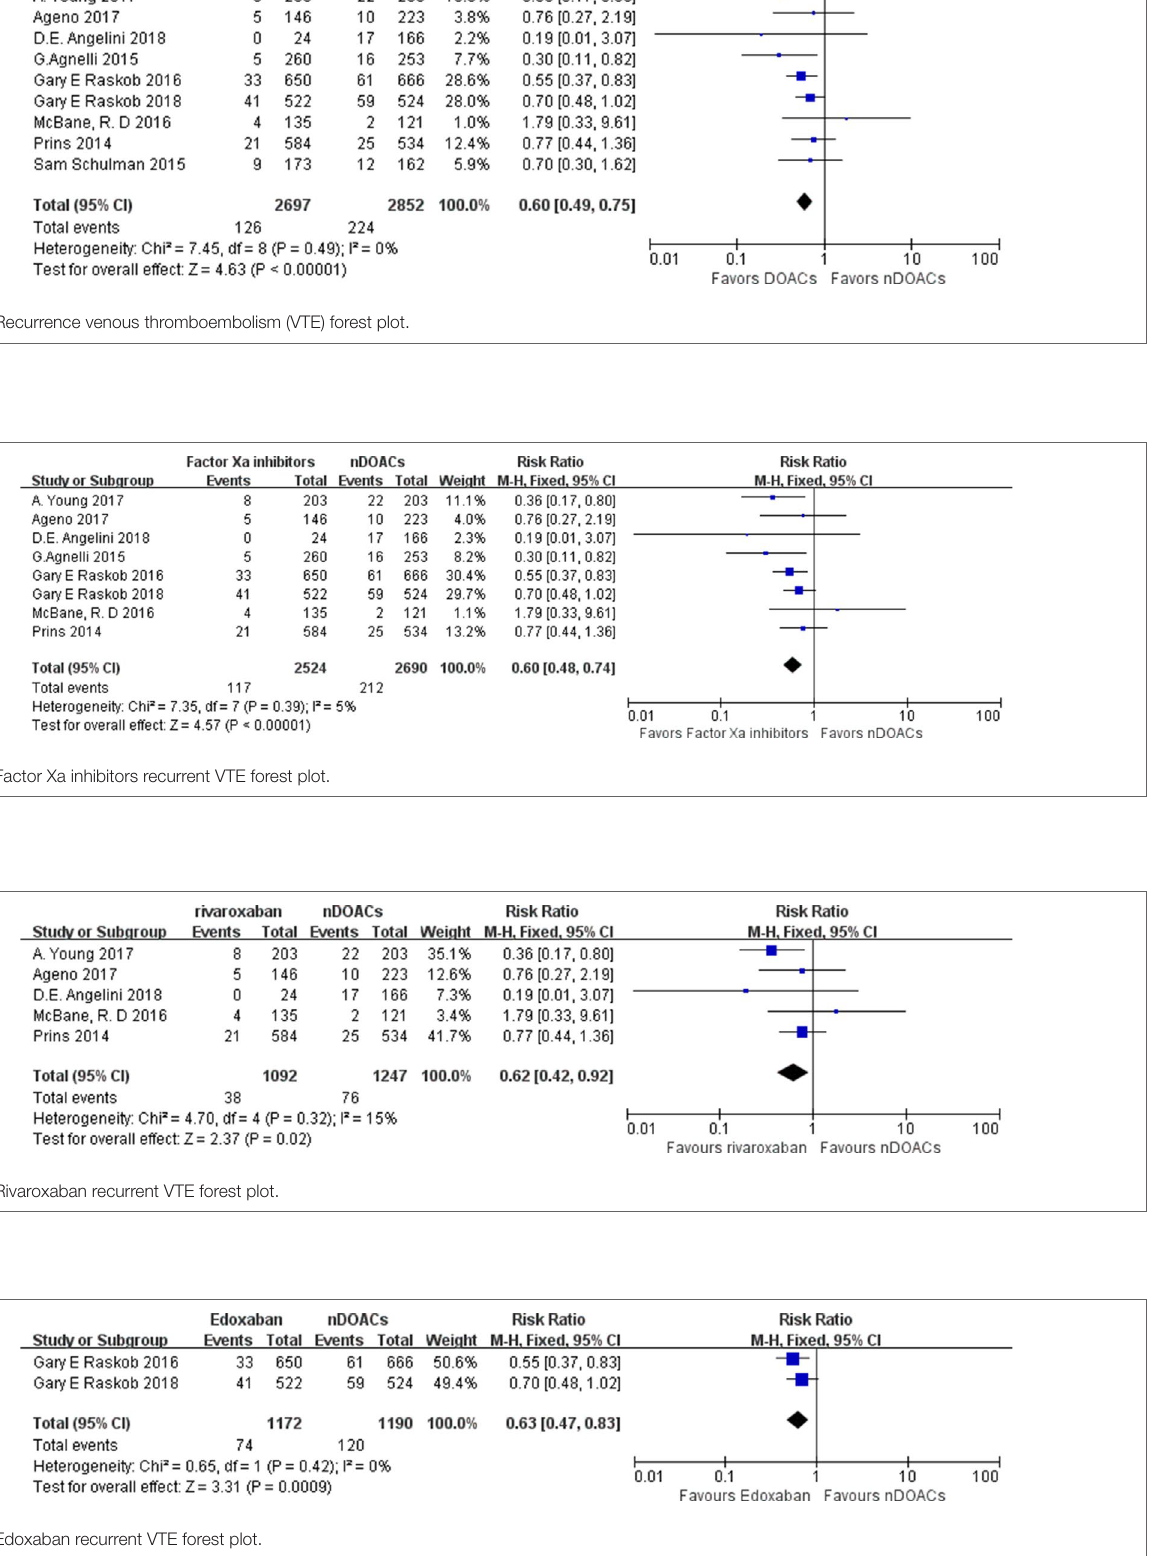
FIGURE 5 | Edoxaban recurrent VTE forest plot.